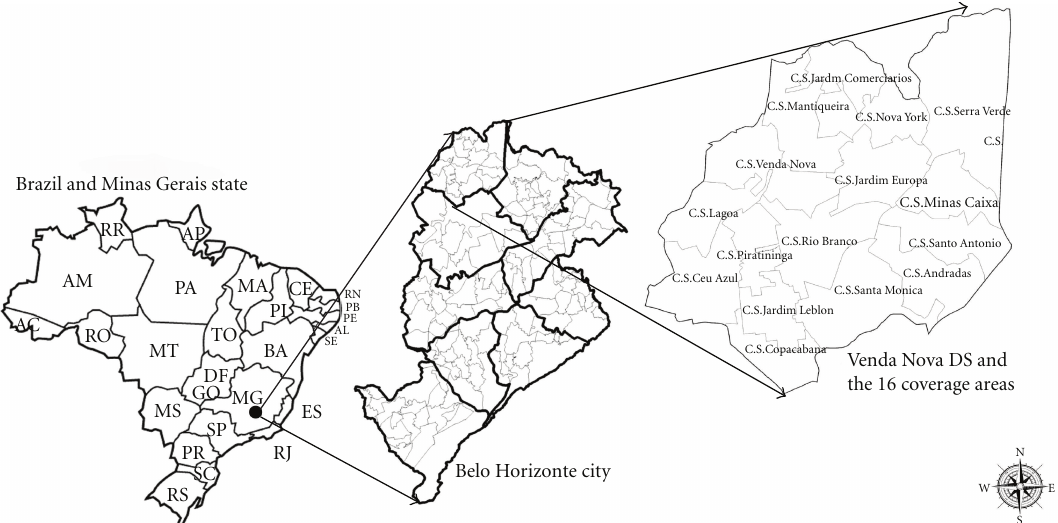
Figure 1: Administrative division of the Municipal District of Belo Horizonte and its location in Minas Gerais and in Brazil and Venda Nova Sanitary District location in the city of Belo